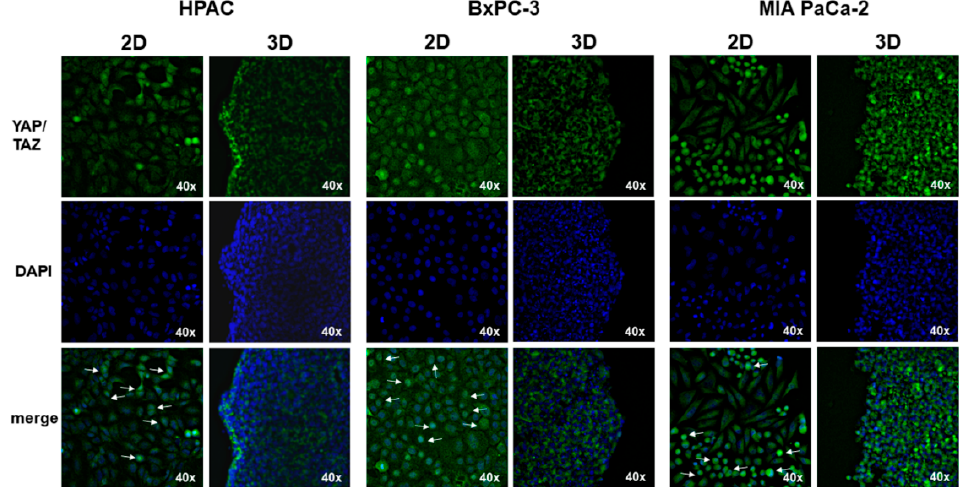
Figure 8. Immunofluorescence analysis for YAP/TAZ (green) in PDAC cells cultured in 2D mono- layers and 3D spheroids. The merged micrographs show that HPAC and BxPC-3 cells grown in 2D monolayers exhibited a more nuclear immunolabeling compared to 3D spheroids (see arrows), having a predominantly YAP/TAZ cytoplasmic localization. Conversely, in MIA PaCa-2 cells YAP/TAZ im- munoreactivity was mostly cytoplasmic in both 2D and 3D cell cultures. Original magnification: 40 ×